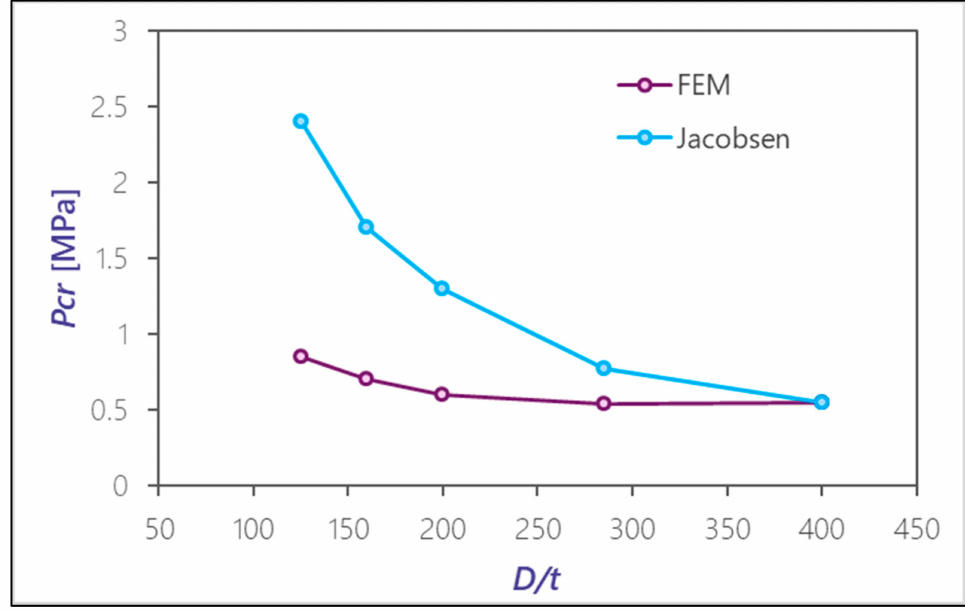
Figure 13. Comparison between Jacobsen and FEM results for critical pressure Pcr